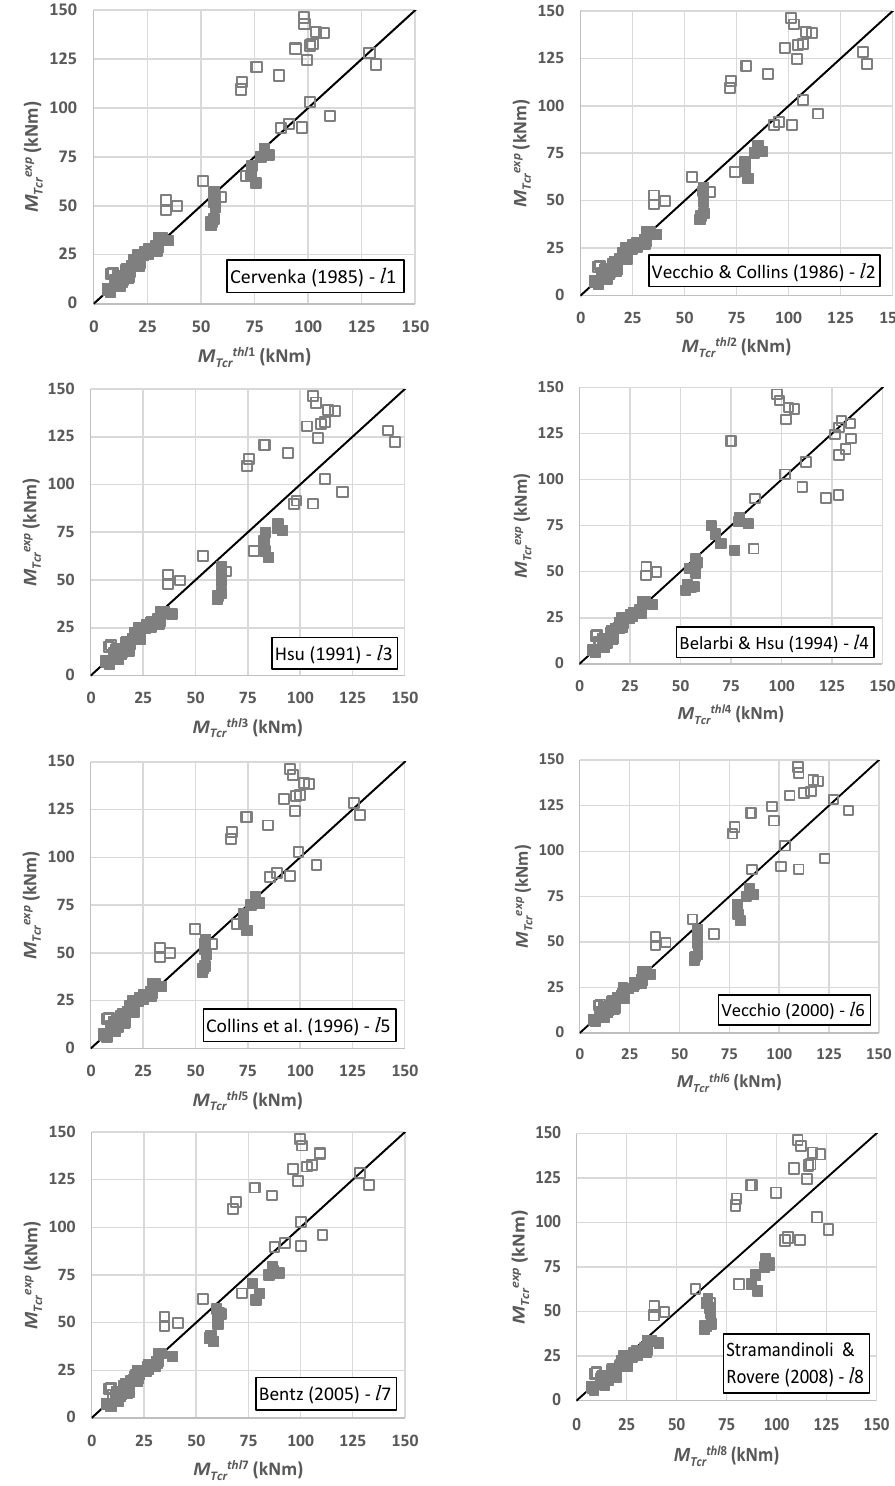
Figure 8. Experimental versos theoretical cracking torque.